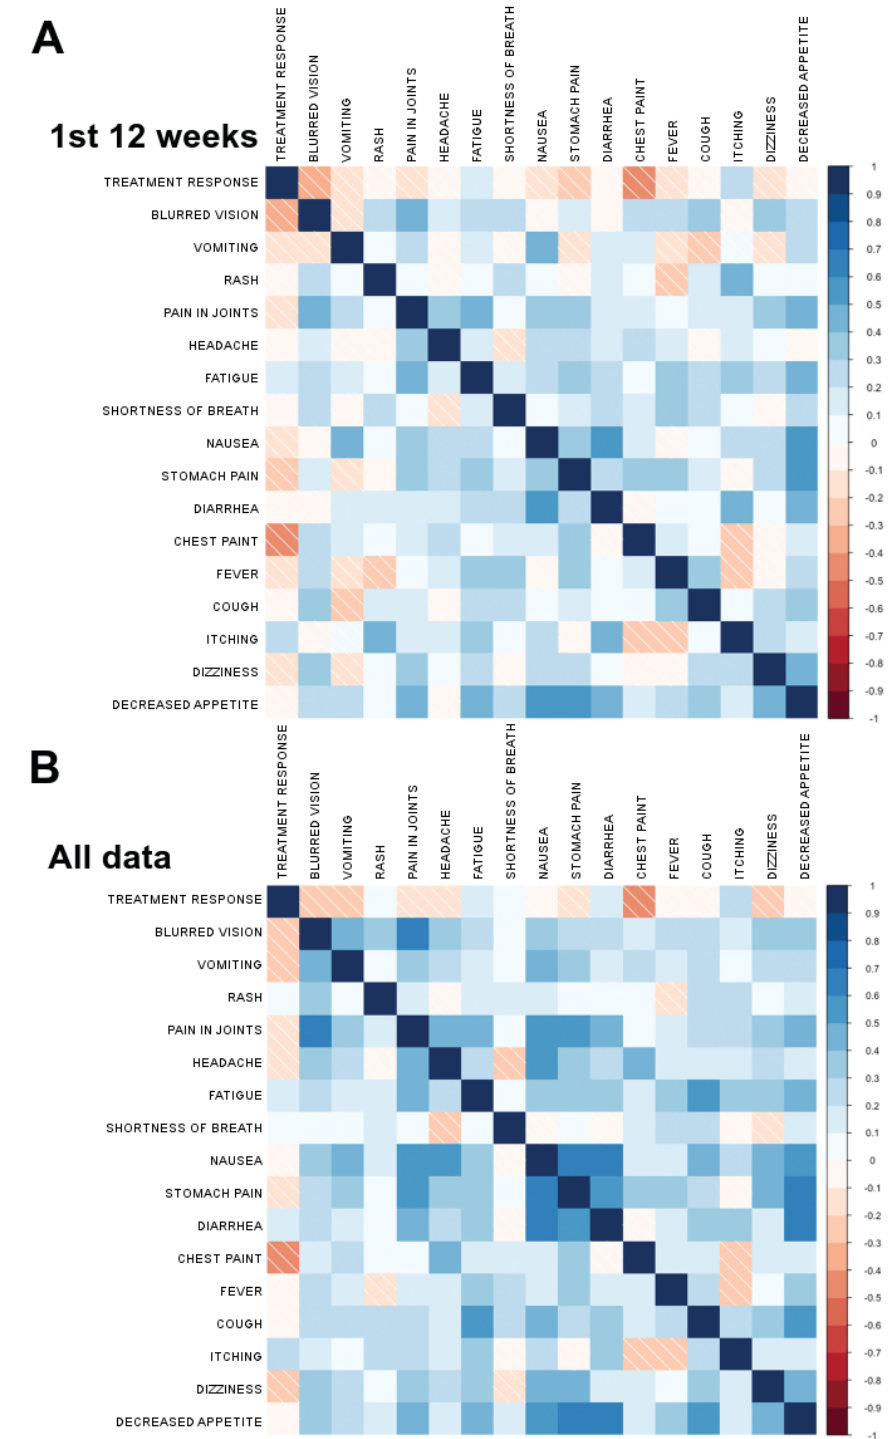
Figure 2. Correlation analysis between different symptoms and treatment benefit (complete response, partial response, or stable disease as a best response) using heat maps during the (A) first 12 weeks of follow-up and (B) entire study. The color intensity signifies the correlation strength (0.5,